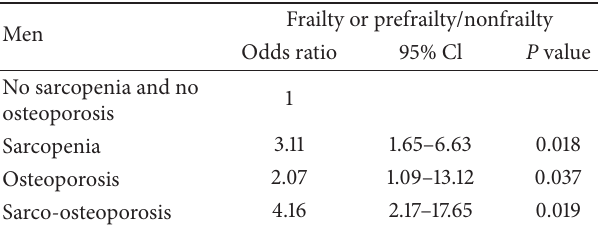
Table 6: Association between sarco-osteoporosis, sarcopenia, or osteoporosis and frailty/prefrailty in men.